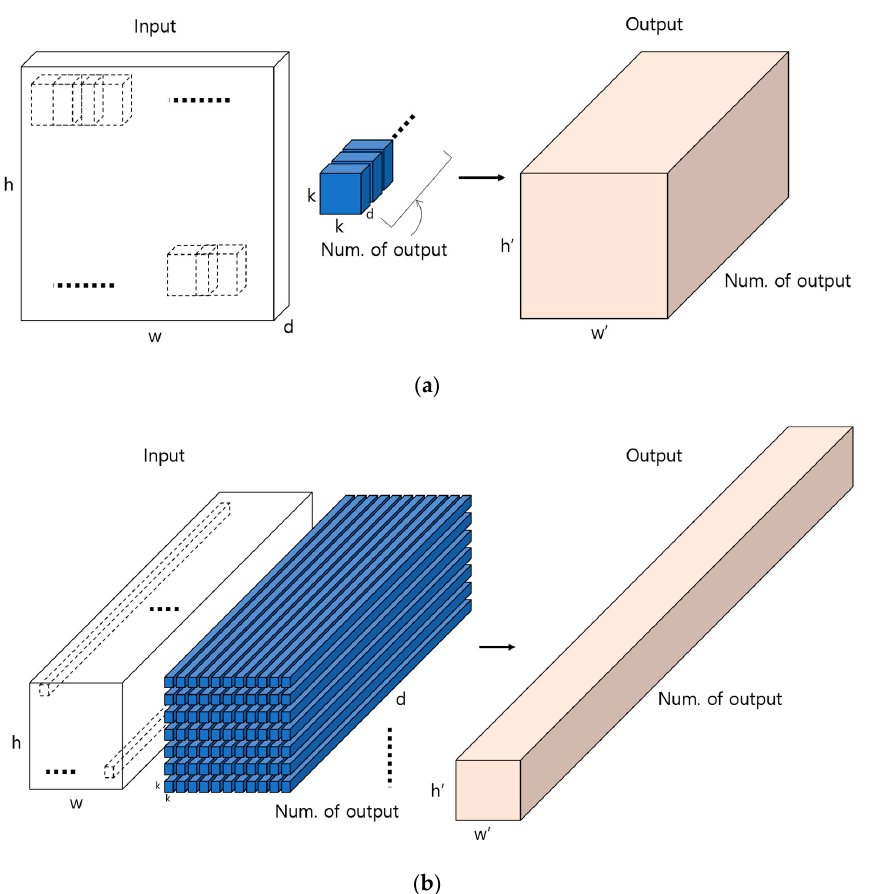
Figure 11. Example of obtaining output feature map via the convolutional layer. ( a ) Example of creating output feature map (w’ × h’ × Num. of output)) using as many as k × k filters of the same depth as the number of output on the input image (w × h × d). ( b ) Example of convolution calculations and finding the output feature map when the input feature map’s depth increases afterward.